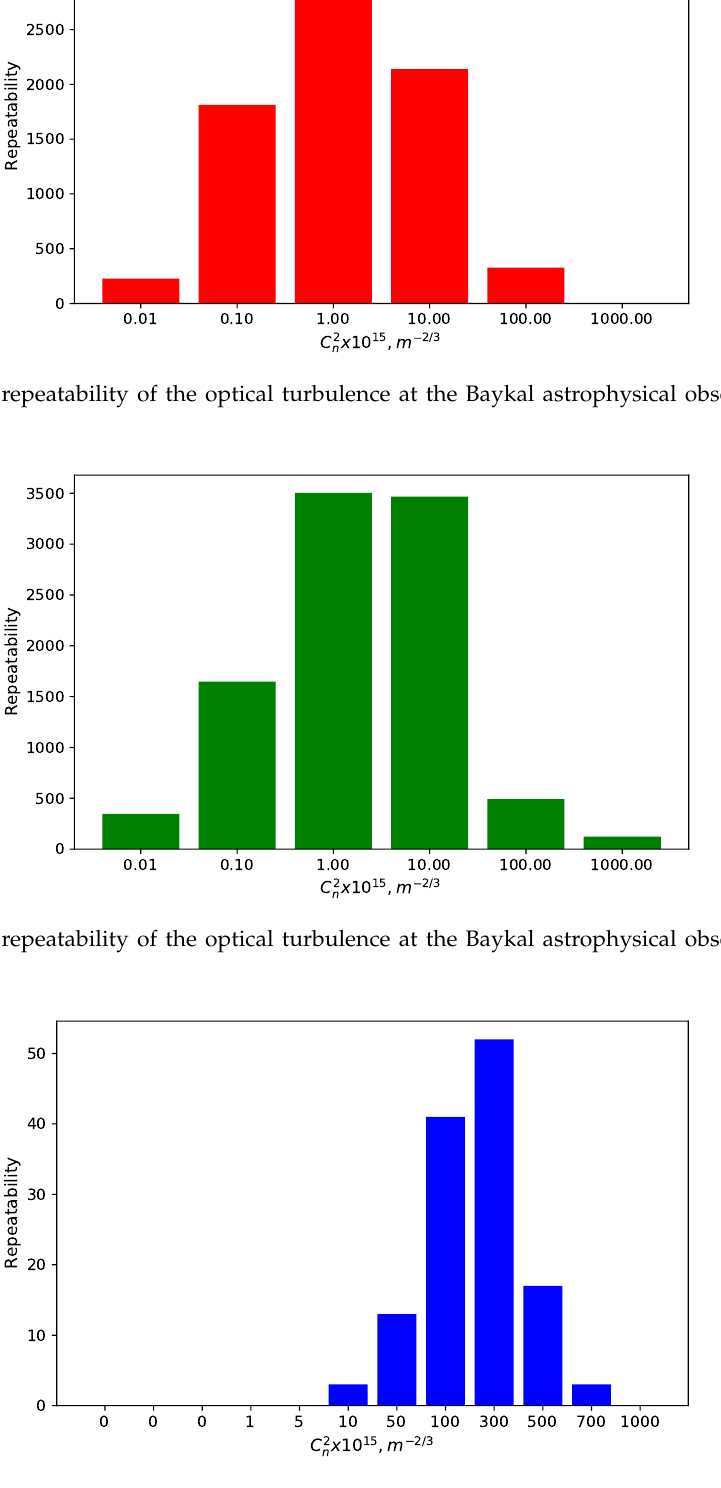
Figure 5. The repeatability of the optical turbulence at the Baykal astrophysical observatory site in